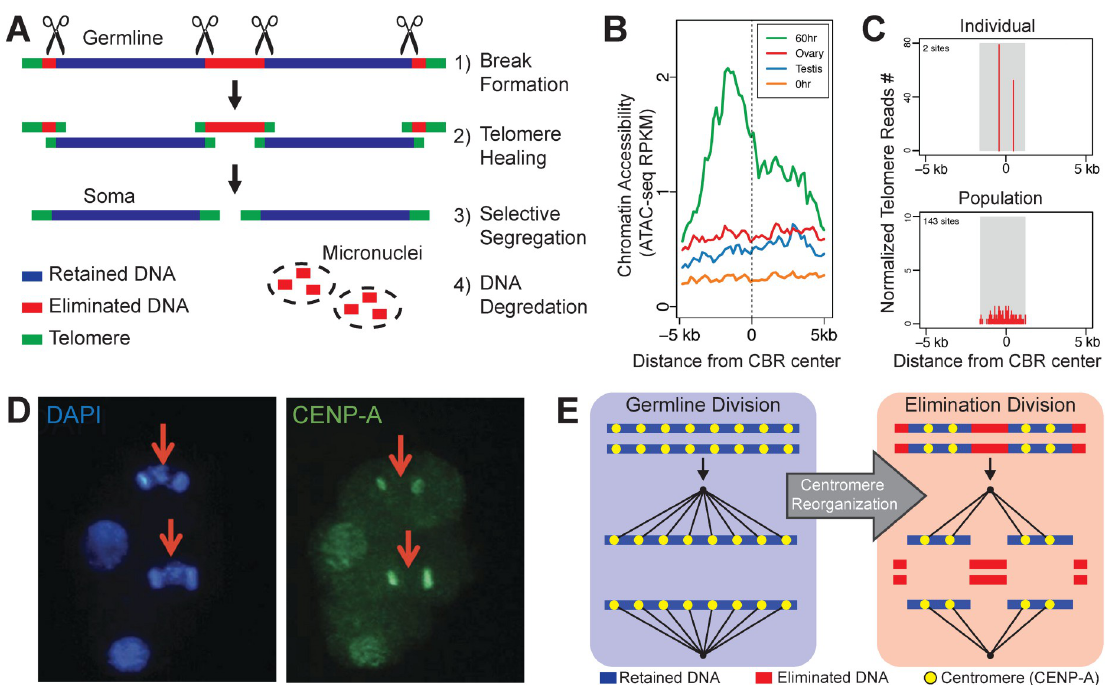
Fig 3. PDE mechanisms. ( A ) A model of PDE process in Ascaris . See text for detailed description. ( B ) ATAC-seq of Ascaris shows CBRs have open chromatin during PDE (60 hours, 4-cell). ( C ) Ascaris telomere addition forms in 3–6-kb regions of the genome. Top: telomere addition from a single worm’s intestine (derived from 1 PDE event) shows 2 telomere addition sites. Bottom: telomere addition from a population of worms shows telomeres are randomly distributed across the CBR. ( B ) and ( C ) adapted from [40]. ( D ) CENP-A staining of a 4-cell embryo with 2 cells undergoing PDE. Eliminated DNA (red arrows) is not stained with CENP-A, suggesting the loss of centromeres in the eliminated DNA. Adapted from [39]. ( E ) A model of centromere reorganization for PDE. Left: germline division with centromeres distributed across the entire chromosome. Right: PDE mitosis with centromeres absent on eliminated regions of the genome. Adapted from [39].